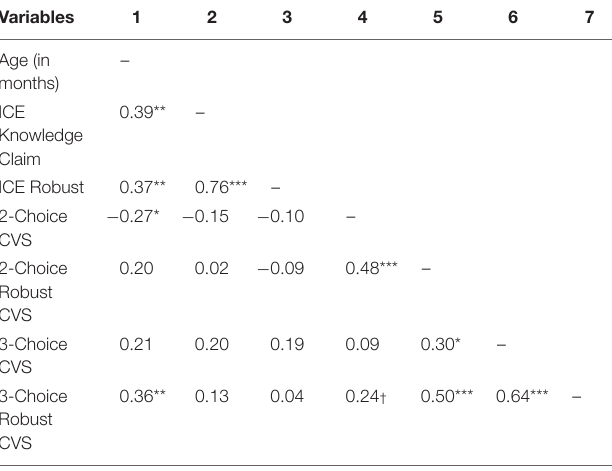
TABLE 5 | Bivariate correlations between the ICE and CVS tasks.